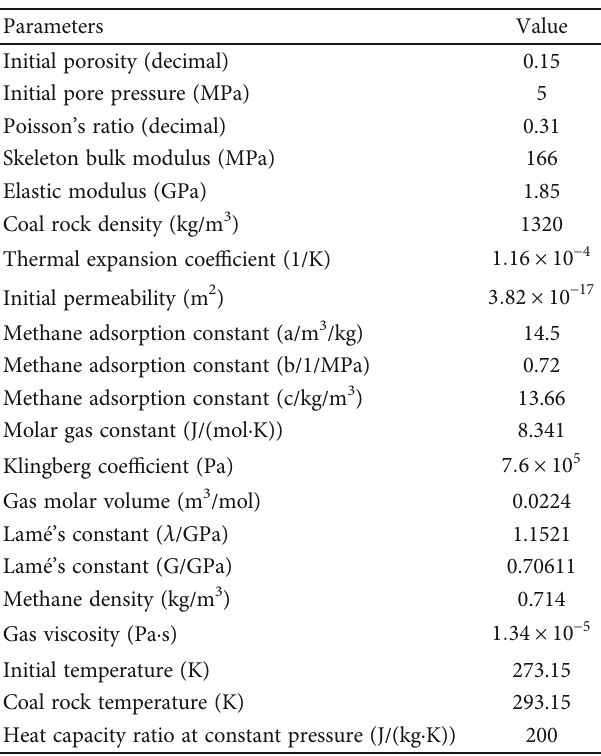
Table 1: Model parameters.